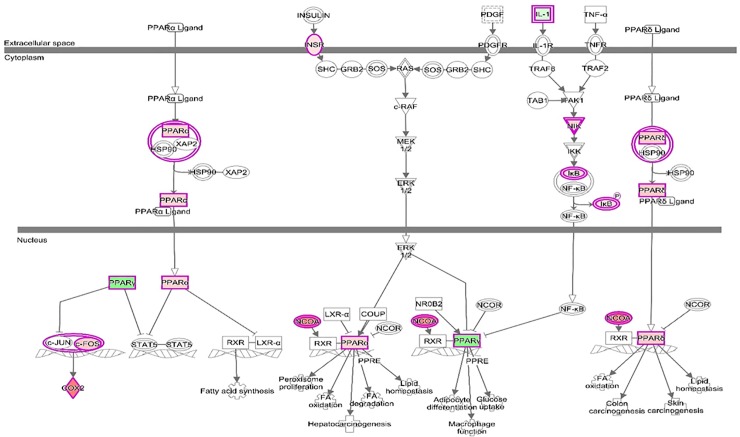
Enrichment of the PPAR signaling pathway in muscle from Iberian fetuses.